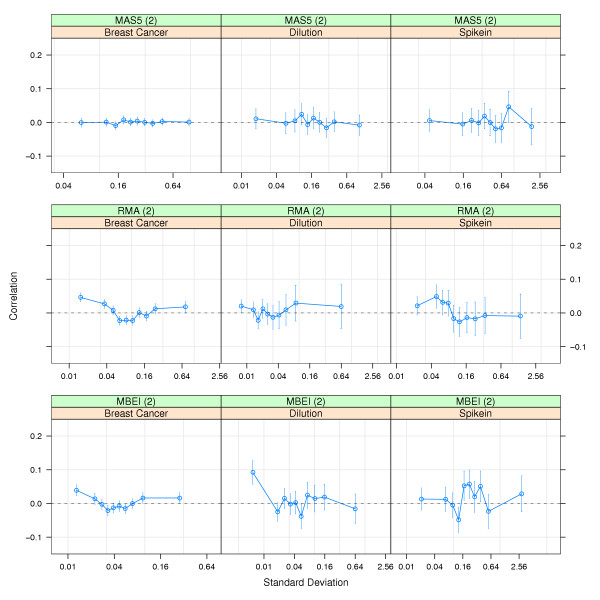
Correlations after renormalizing the expression measures using the pairwise loess normalization on the probe set level. Except for the second normalization step, this is identical to the lower half of Figure 2, including the scaling of the axis to facilitate the comparison. The MAS5 values appear now well normalized throughout, whereas RMA and MBEI still show a similar pattern of residual correlation, although on a clearly reduced level.